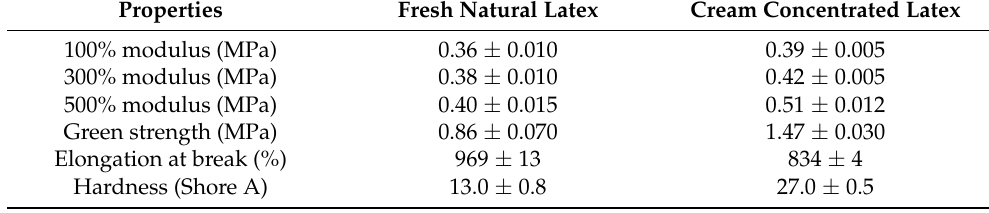
Table 7. Mechanical properties of fresh natural latex and cream concentrated latex from RRIM600 clone.